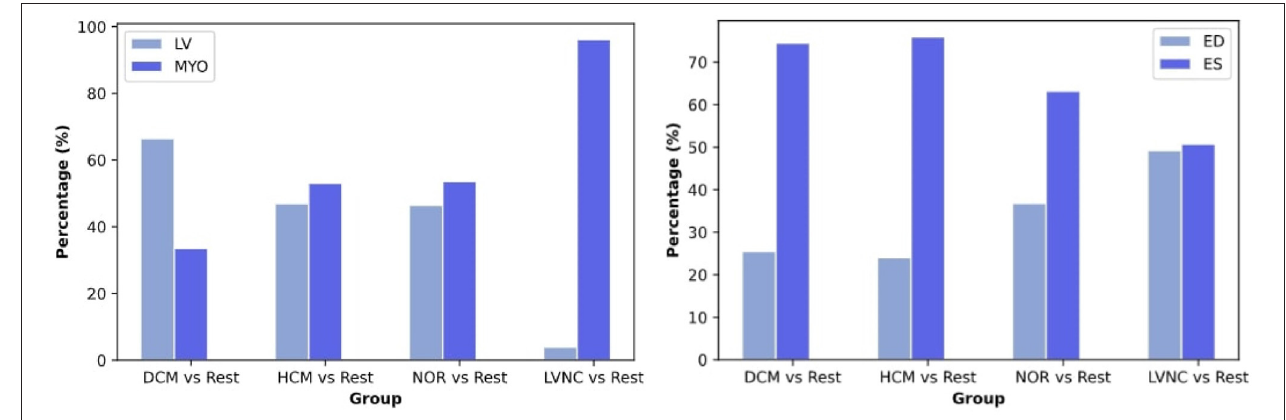
FIGURE 5 | Distribution of the selected radiomics features across the cardiac structures [ left image, i.e., LV myocardium (LVMYO) vs. LV blood pool (LV)] and cardiac cycle phase ( right image). For this analysis, all the radiomics selected by the RF model were used.